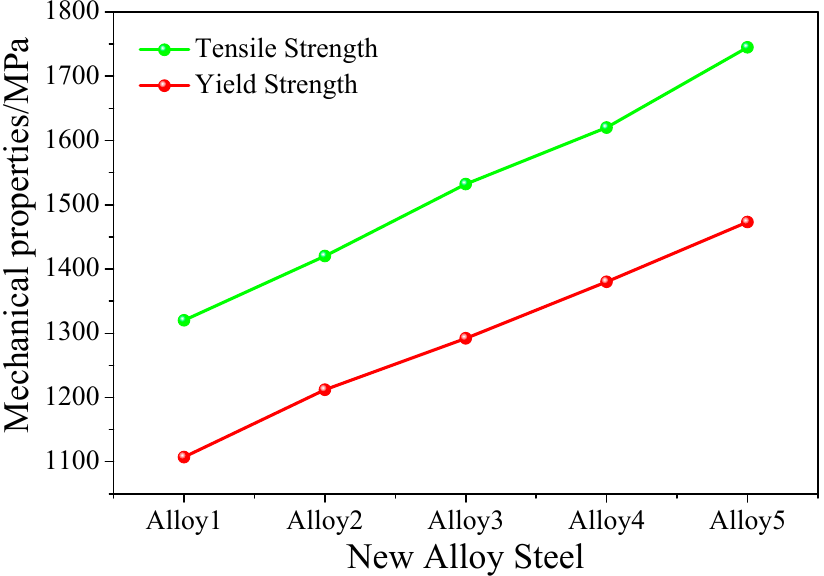
Figure 10. Tensile strengths and yield strengths of Alloy1 ∼ Alloy5.